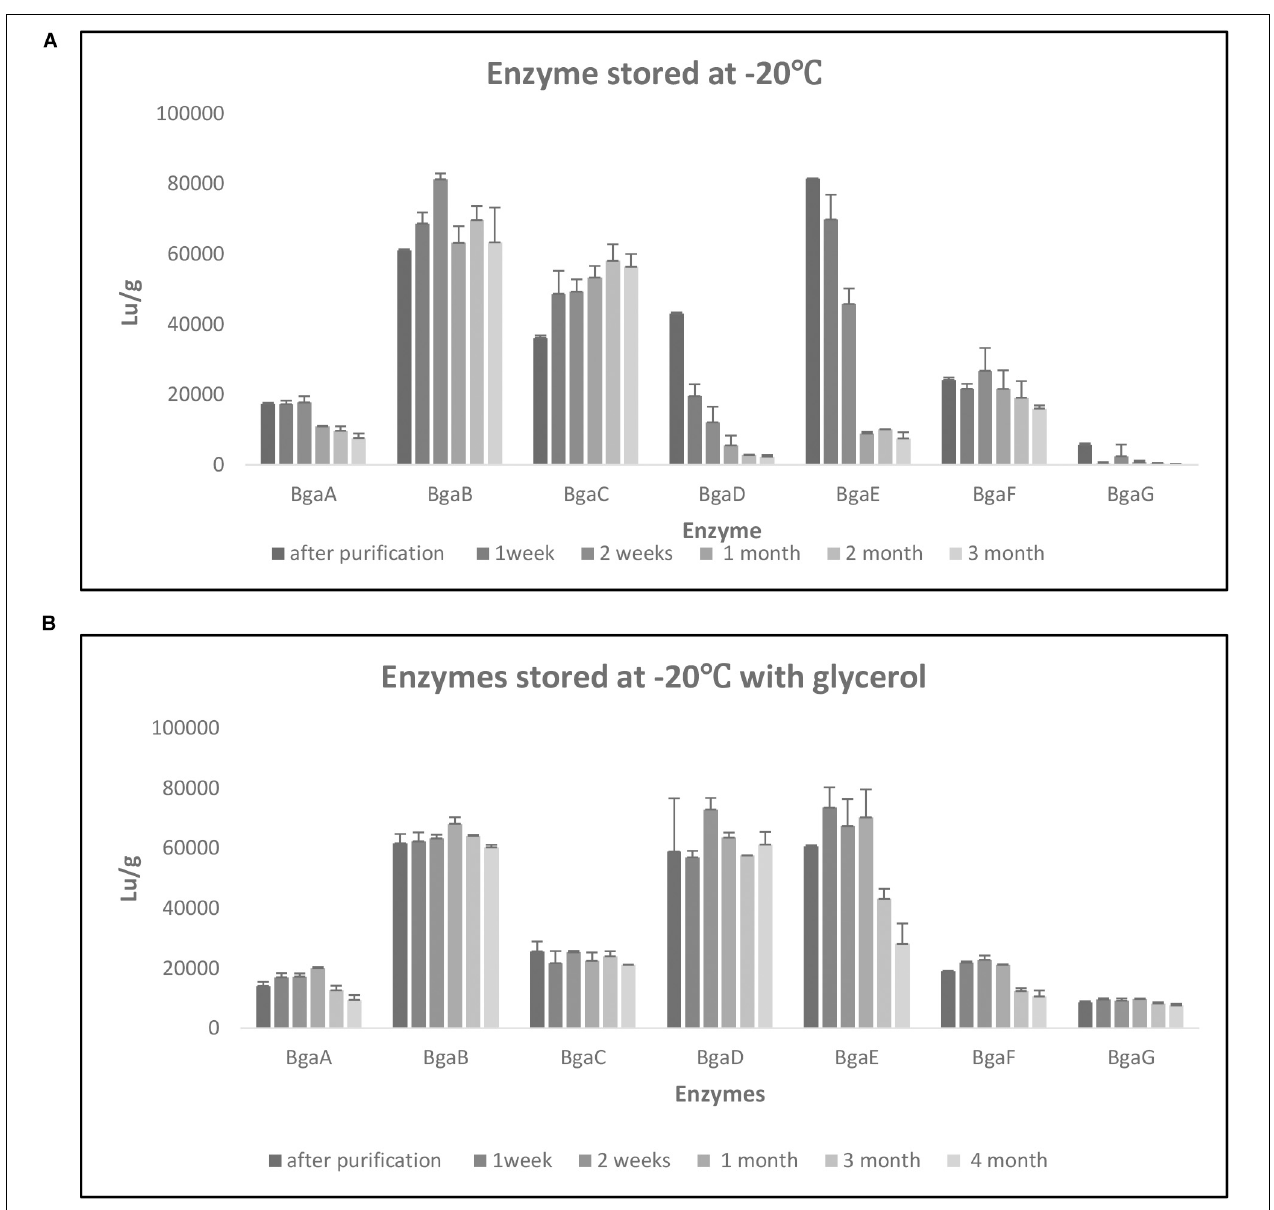
FIGURE 2 | Enzyme stability. Evaluation of enzyme stability under different storage conditions at –20 ◦ C for 3 months (A) and –20 ◦ C with glycerol for 4 months (B) . Data represent the mean of two independent experiments. The enzymatic activity was express in Lu/g as per Materials and